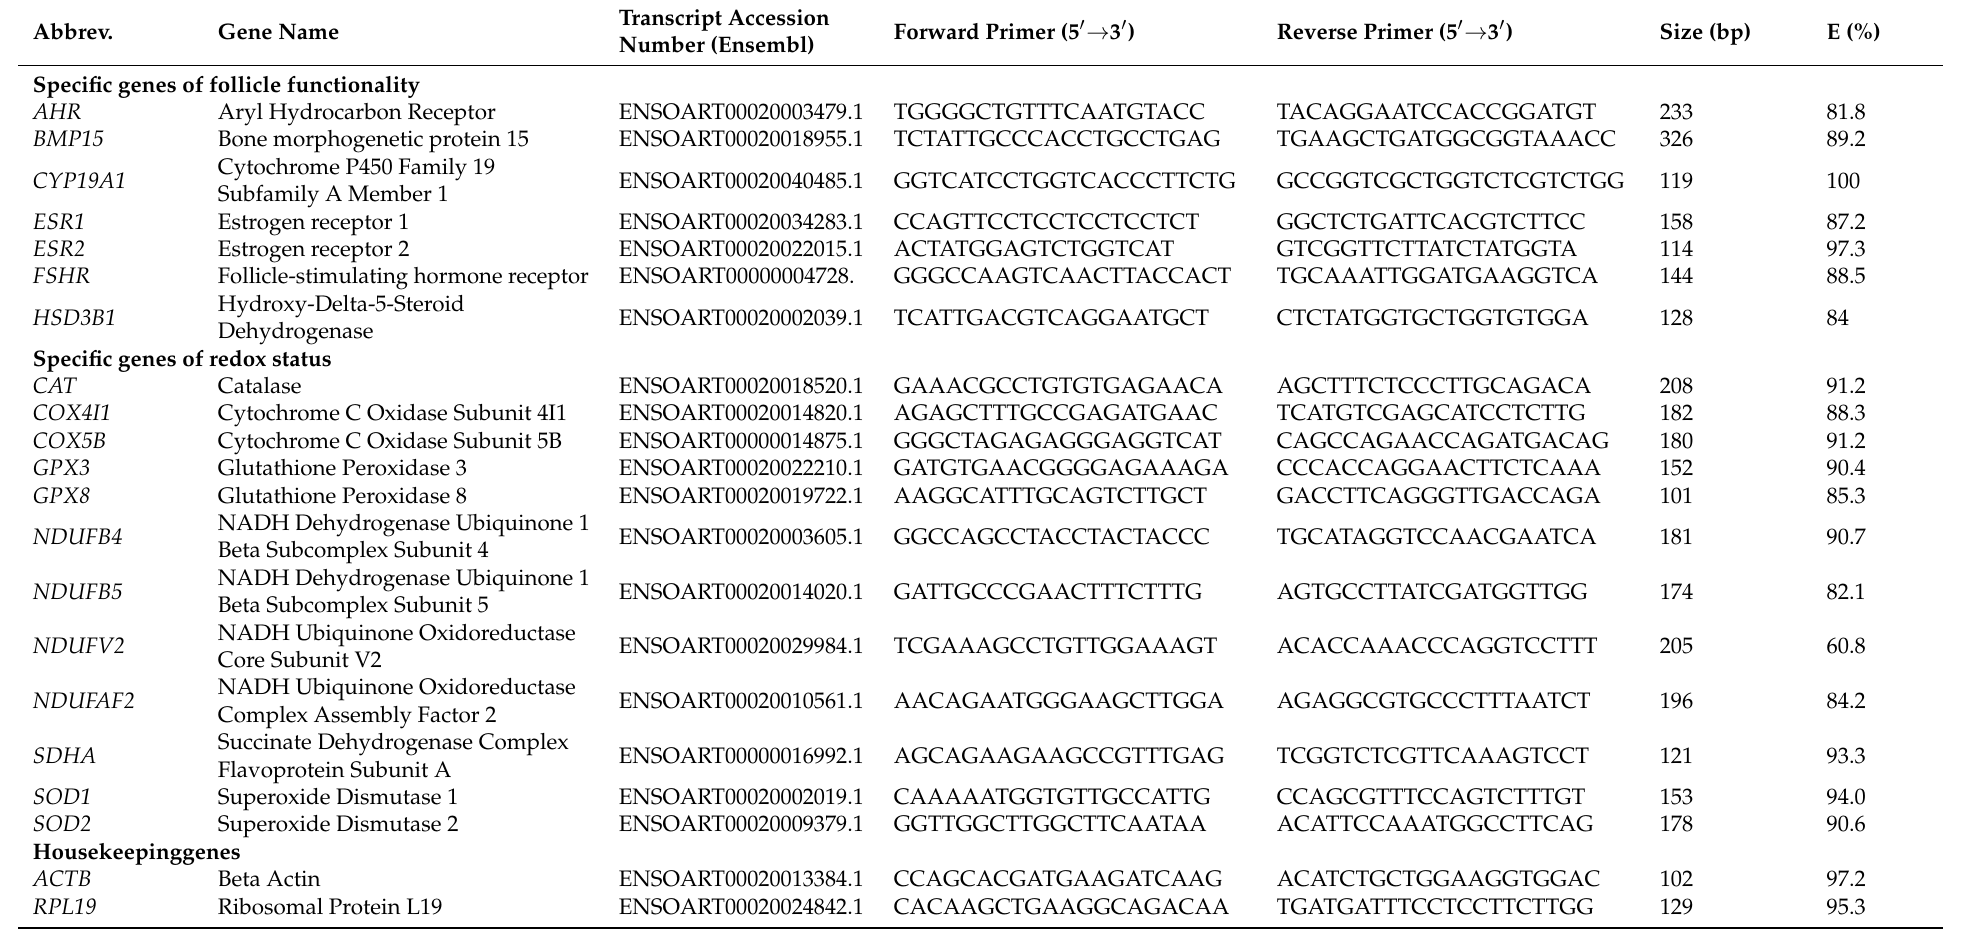
Table 1. Primer sequences for real time reverse transcription polymerase chain reaction used in this